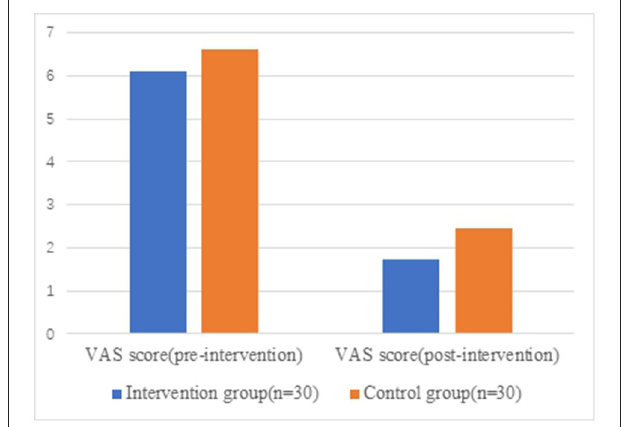
FIGURE 2 | VAS score between groups. VAS, visual analog scale.